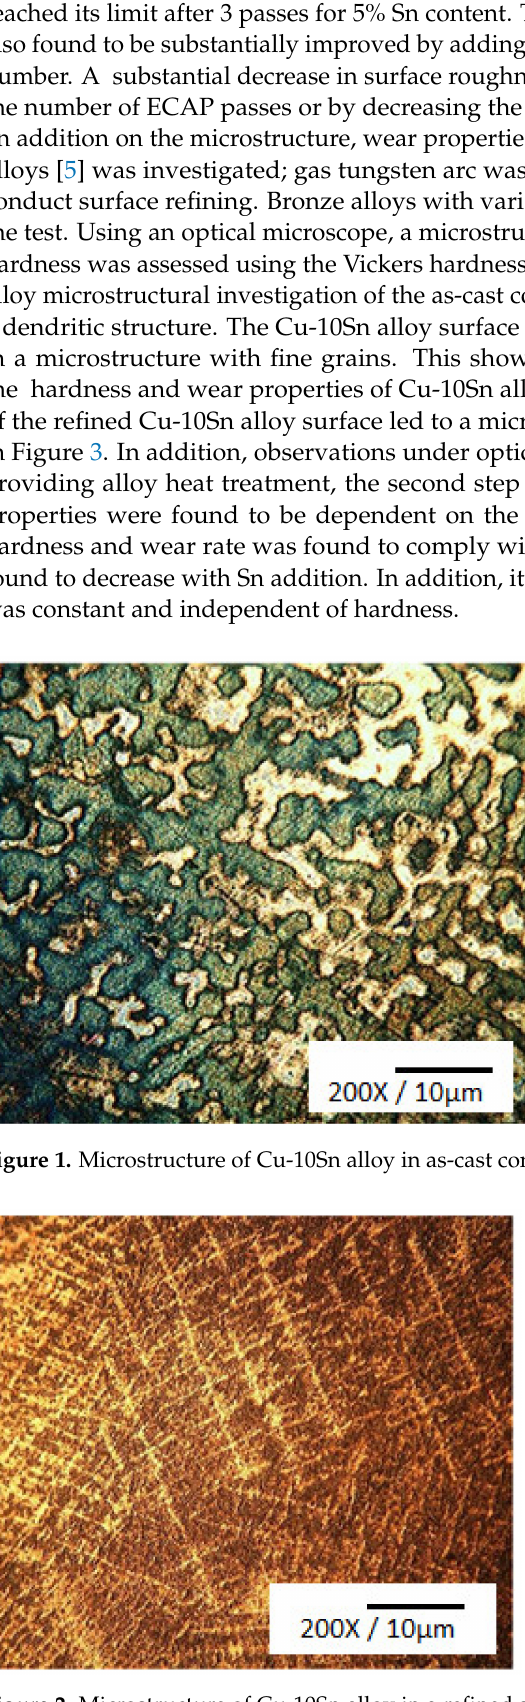
Figure 2. Microstructure of Cu-10Sn alloy in a refined state